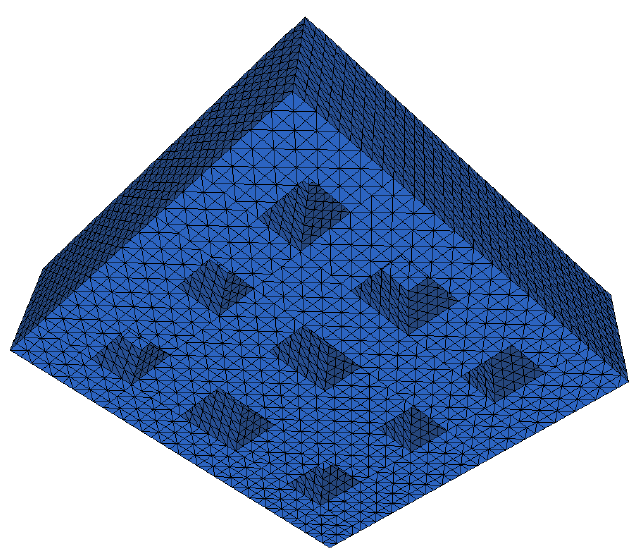
Figure 3. Computational domain for the control problem (12,736 elements).